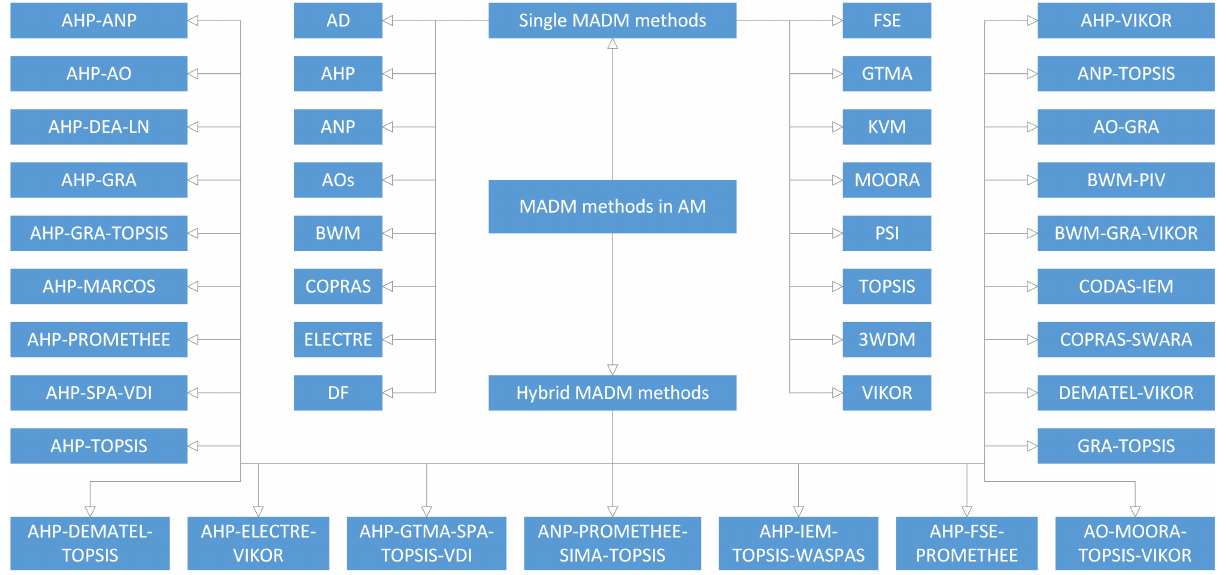
Figure 5. Classification of the MADM methods applied in